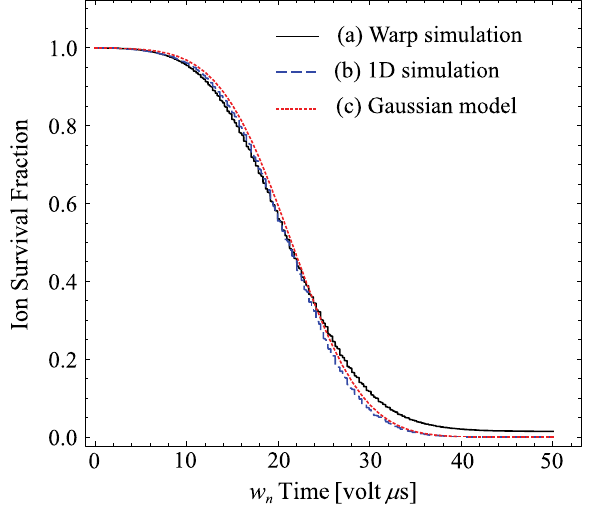
FIG. 14. Comparison of ion loss fractions evaluated from three independent numerical models.